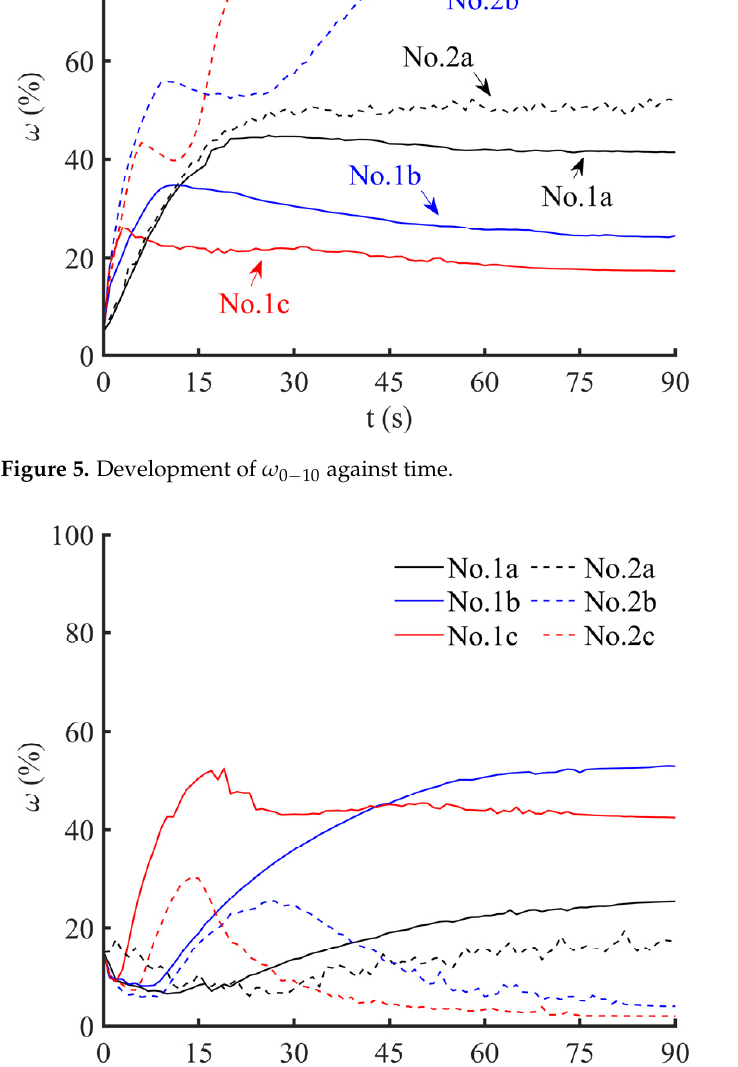
Figure 6. Development of 𝜔 The development curves of 𝜔